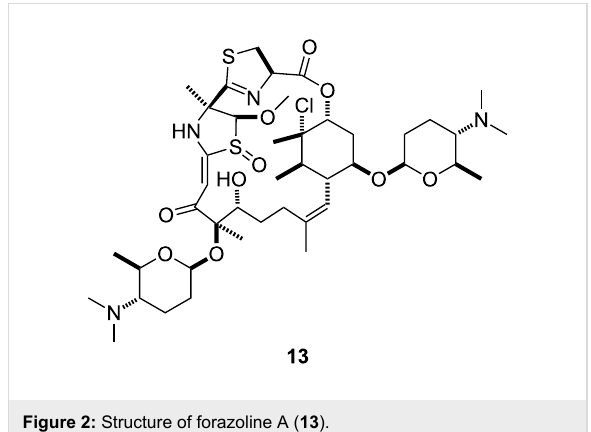
Figure 2: Structure of forazoline A ( 13